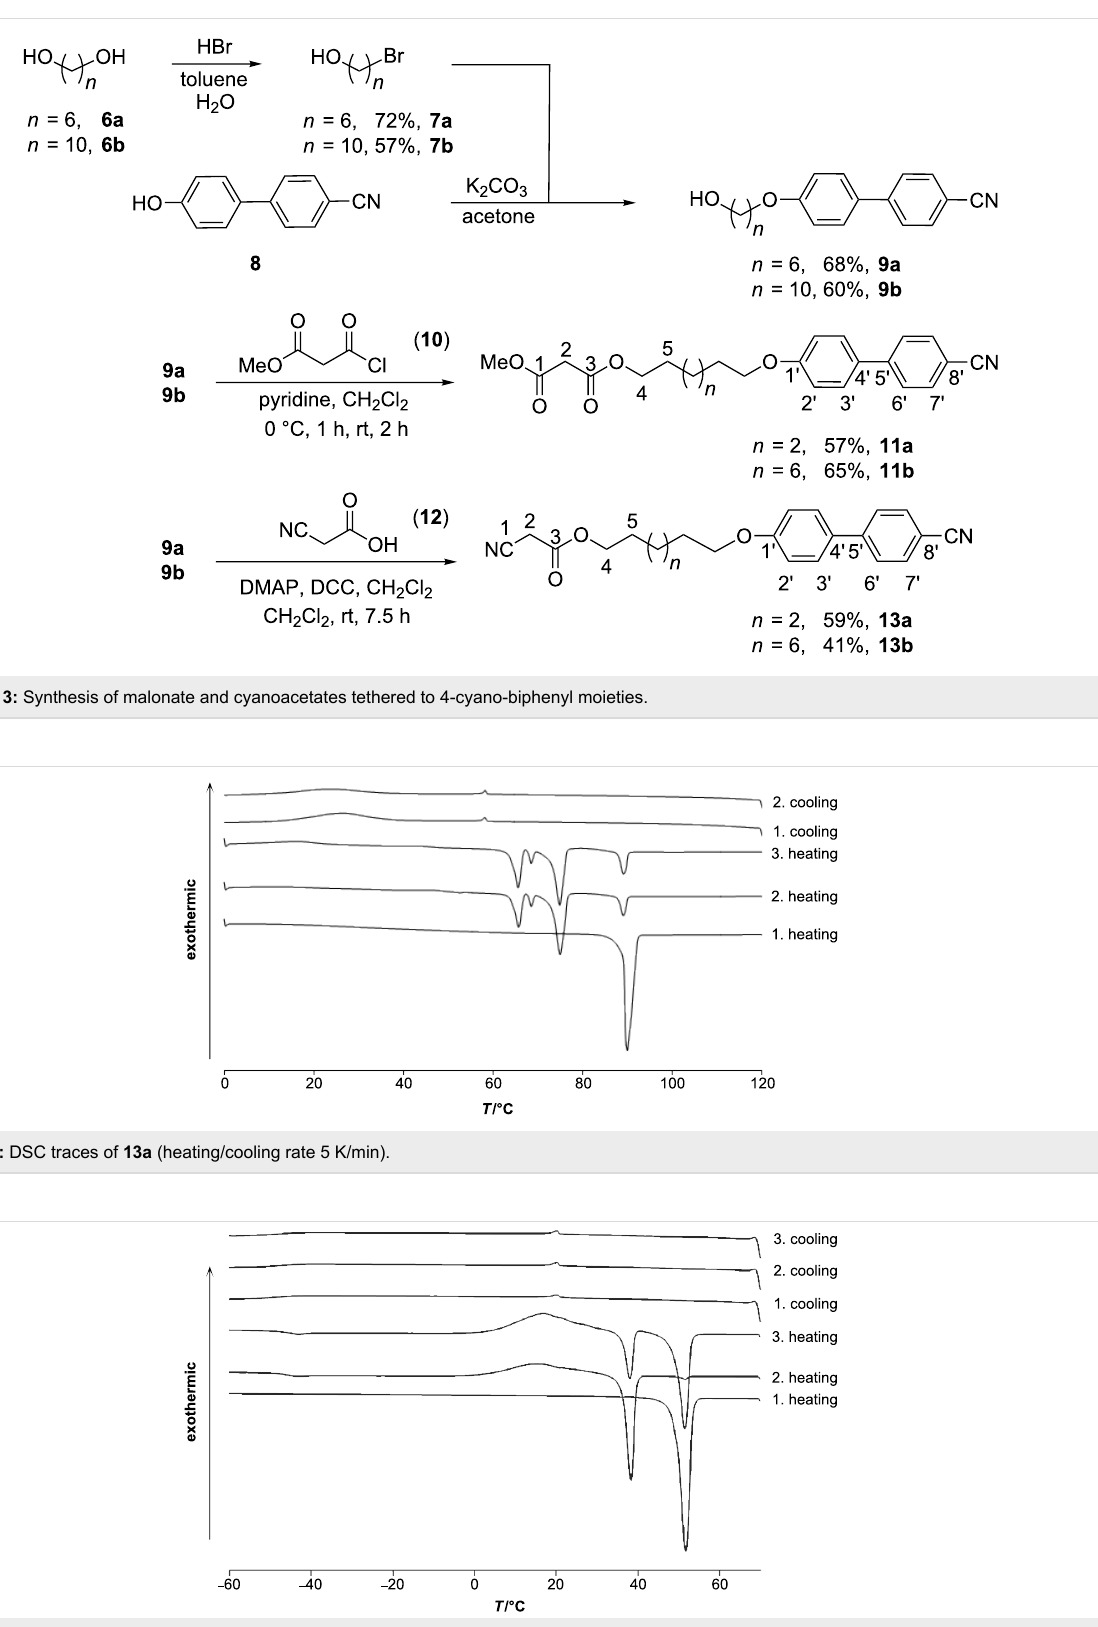
Figure 2: DSC traces of 11a (heating/cooling rate 10